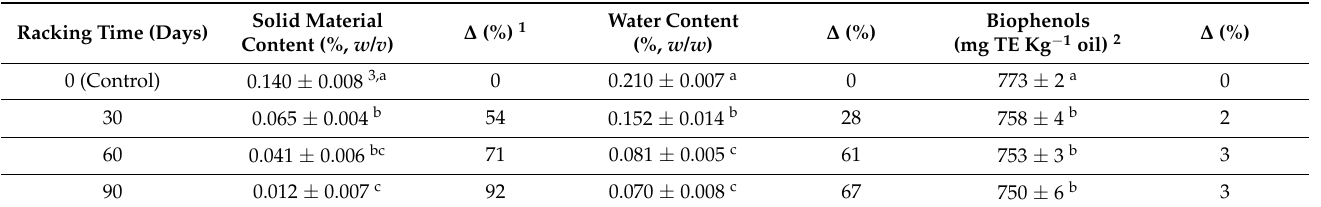
Table 1. Physicochemical characteristics of Coratina monocultivar EVOO during three months of